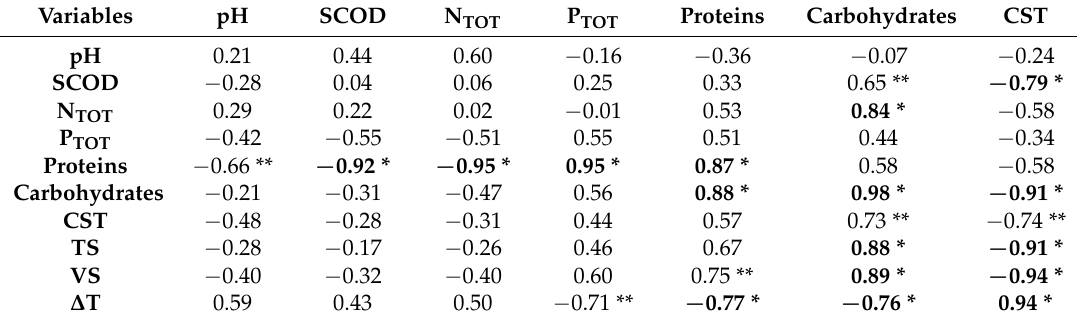
Table A3. Pearson’s correlation coefficients for the direct effects of WAS ultrasonic disintegration (ultrasonic washer).